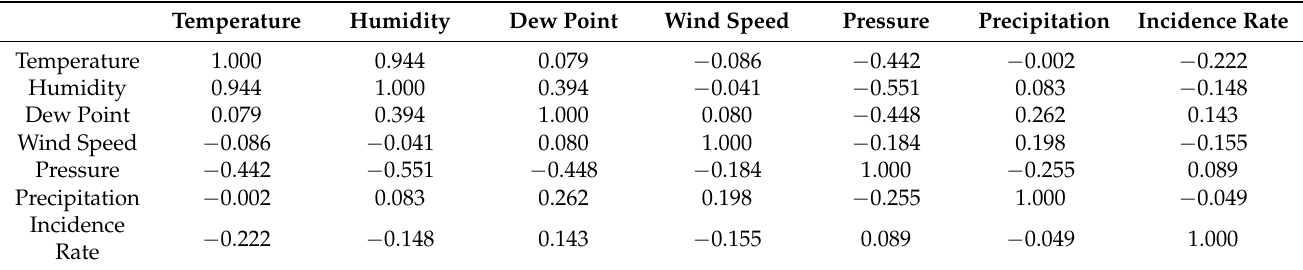
Table 3. Correlation between the variables of the data set. Variables include Temperature,